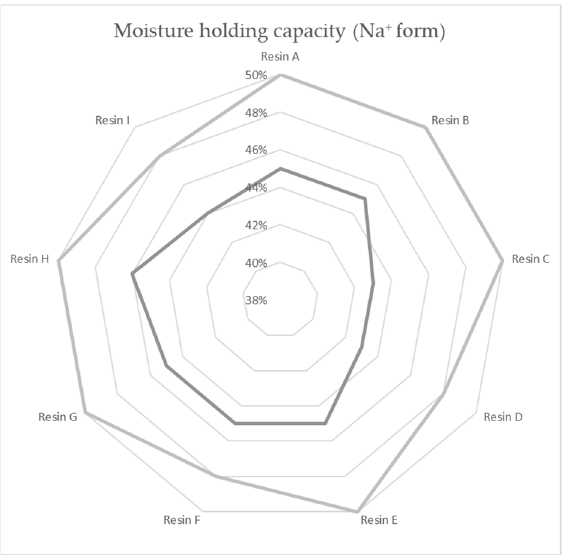
Figure 2. Moisture holding capacity of resin specimens according to the technical data sheets.